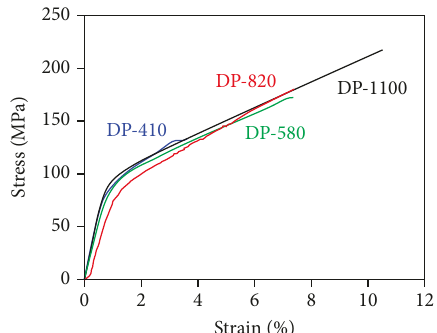
Figure 5: Typicalstress-straincurvesinuniaxialtensionforcellulose nano fi bril networks prepared from nanocelluloses with di ff erent degrees of polymerization (DP). DP = 410 (blue); DP = 580 (green); DP = 820 (red); DP = 1100 (black) solid lines. Reproduced from reference [31] with permissionfrom the American